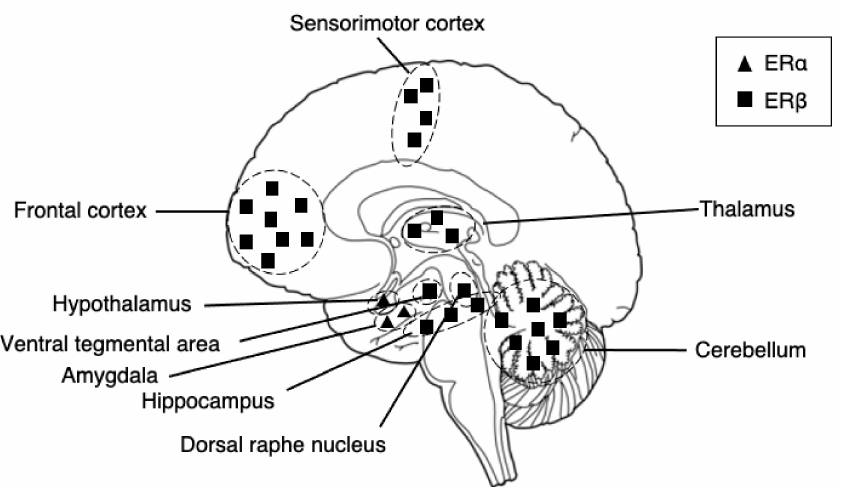
Figure 1. A schematic diagram of distributions of estrogen receptor alpha and estrogen receptor beta in our brains. The receptors have a different predominance of expression in distinct regions. ER α is predominantly expressed in the amygdala and hypothalamus, whereas ER β is predominantly expressed in the somatosensory cortex, hippocampus, thalamus, and